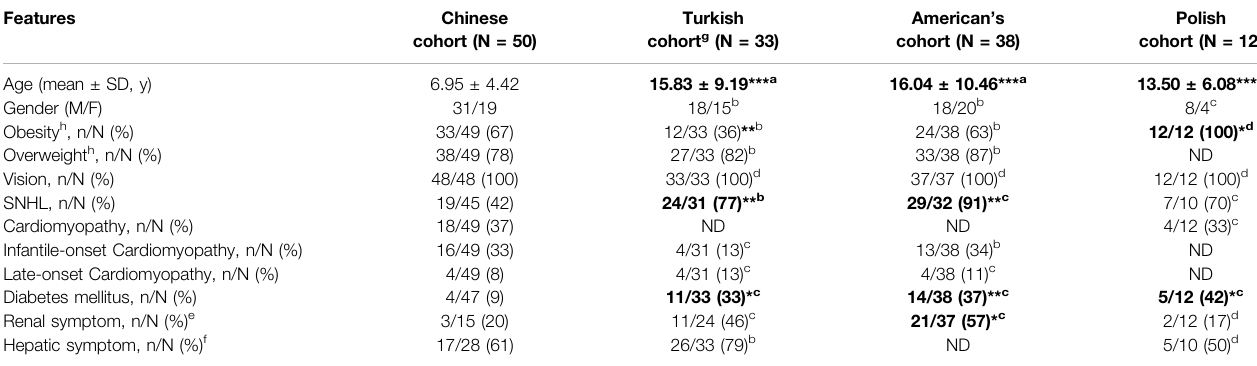
TABLE 1 | Features of our Chinese cohort compared with other